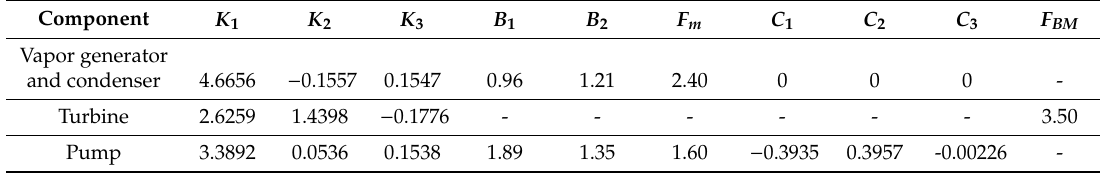
Table 2. Coe ffi cients for determining costs of system